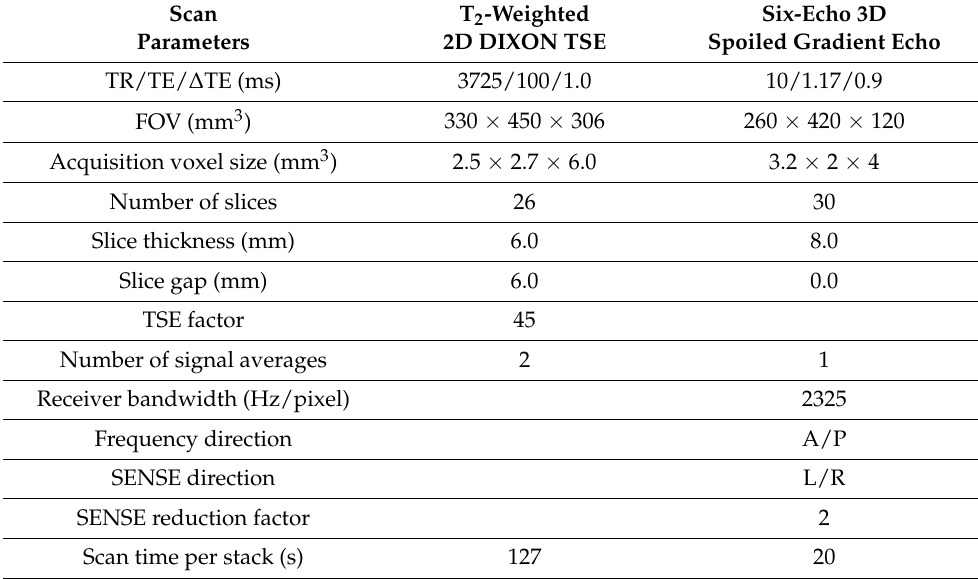
Table 1. Sequence